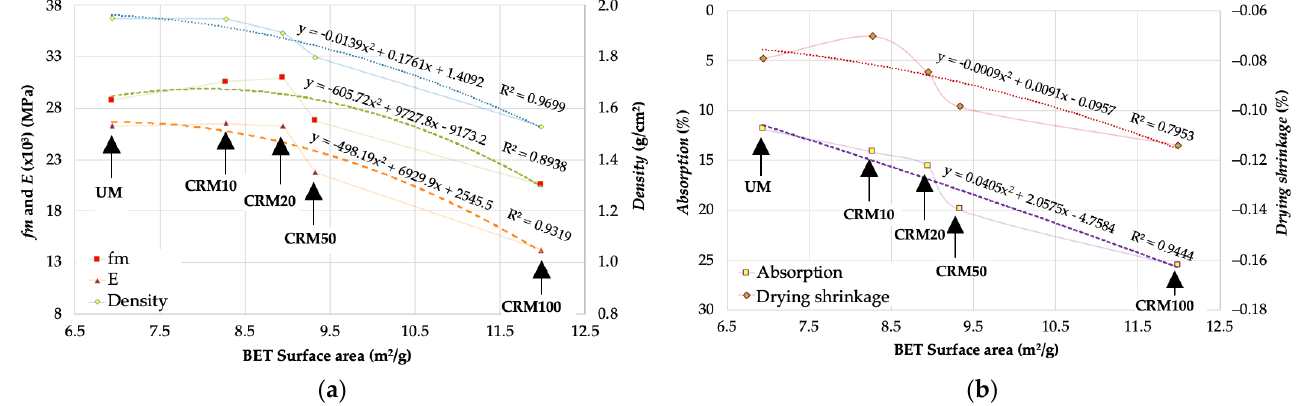
Figure 12. Correlation of BET surface area and: ( a ) fm , E and density ; ( b ) absorption and drying shrinkage .